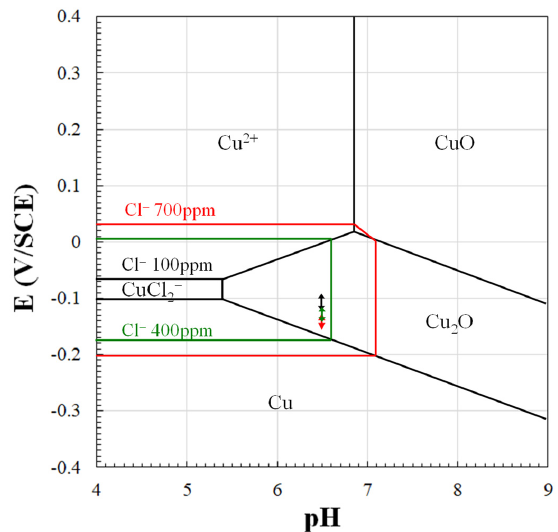
Figure 21. Potential-pH diagram for the system Cu-Cl - -H 2 O at 25 °C for the three different chloride concentrations. The black, green, and red lines delimit the CuCl 2- stability region at 100, 400, and 700 ppm, respectively. The double arrow lines at pH 6.5 show the range of E cor variability for the alloys during the 24 h immersion in 100 (black double arrow line), 400 (green double arrow line), or 700 ppm chlorides (black double arrow line). Figure constructed for a total dissolved Cu species activity of 10 − 6 M.